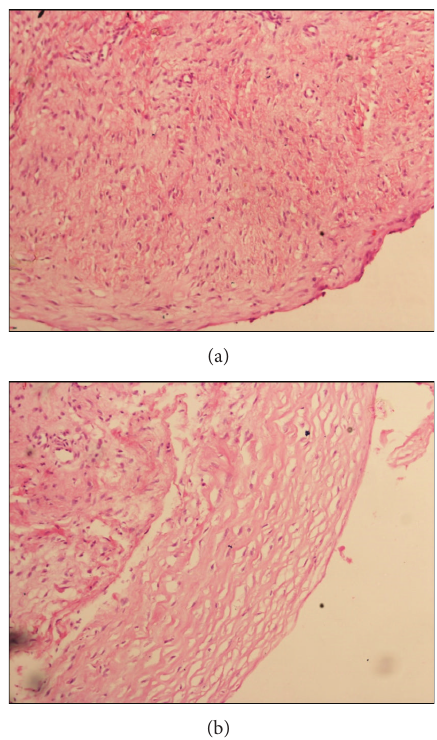
Figure 2: Light microscopy (10x) images of wall of ganglion